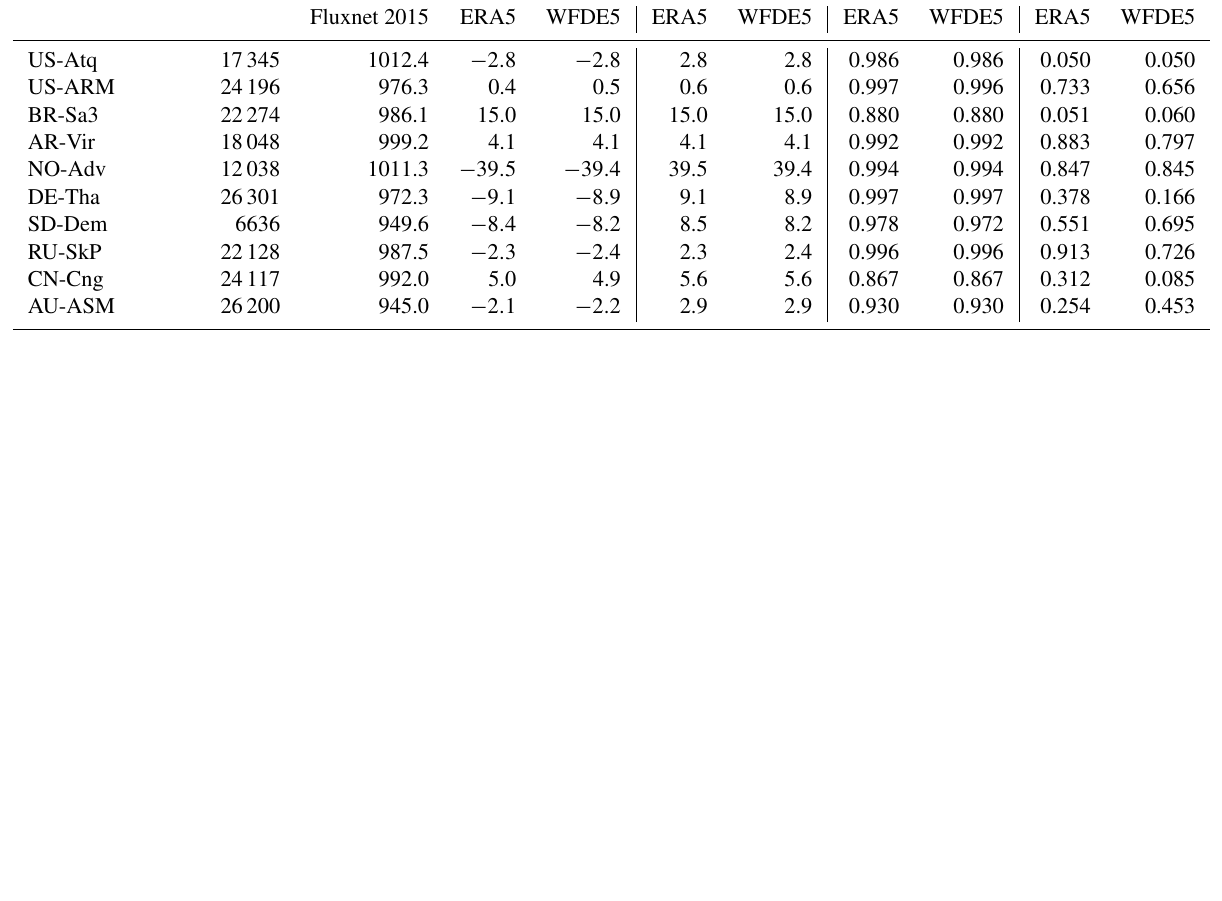
Table A2. PSurf metrics for each FLUXNET2015 site: ERA5 versus FN2015 and WFDE5 versus FN2015 at hourly time steps. PSurf